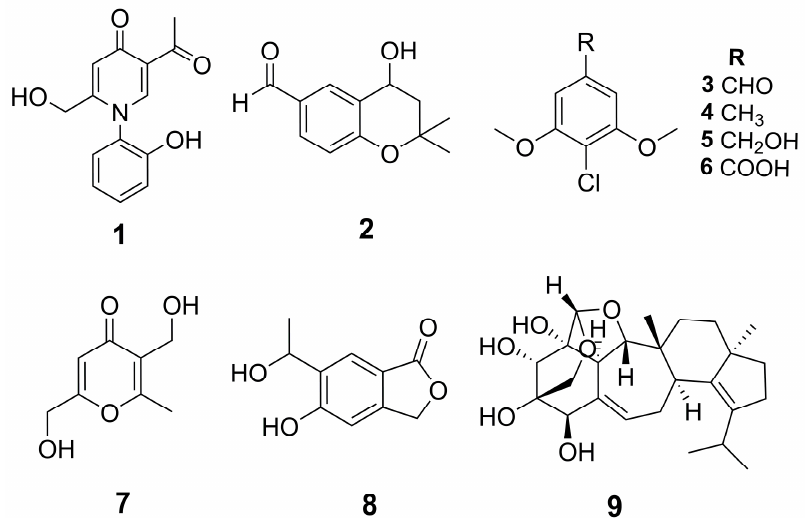
Figure 3. Structures of isolated compounds 1 – 9 elucidated by NMR (Tables 1 and 2).